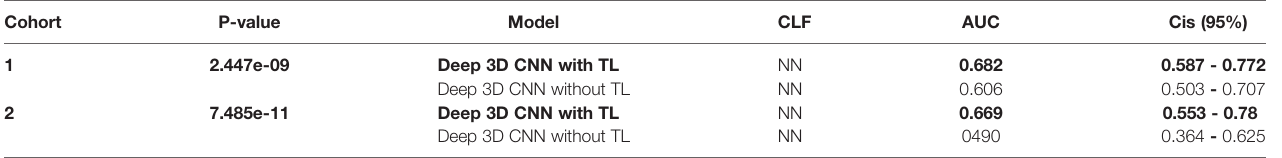
TABLE 2 | Performance comparison for transfer learning in Cohort 1 and 2. Cohort